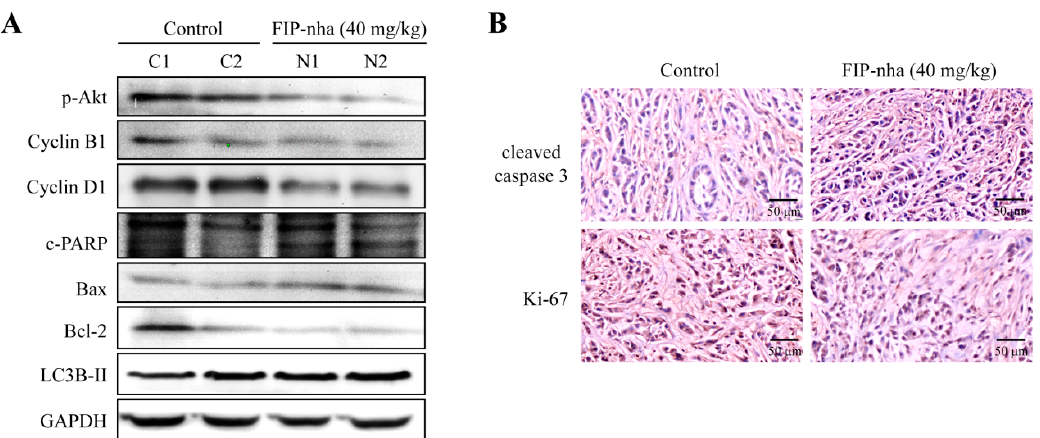
Figure 6. ( A ) The levels of p-Akt, cyclin B1, cyclin D1, c-PARP, Bax, Bcl-2, and LC3B-II in xenograft tumors were determined by western blotting. The experimental group (N1 and N2) was treated with 40 mg/kg FIP-nha, and the control group (C1 and C2) was treated with the same volume of PBS. ( B ) IHC of cleaved caspase 3 and Ki-67 in xenograft tumors. Each group contained three mouse tumors.